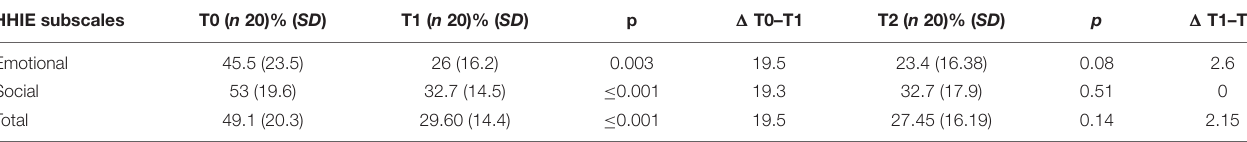
TABLE 5A | HHIE scores and p -value with Bonferroni corrections.